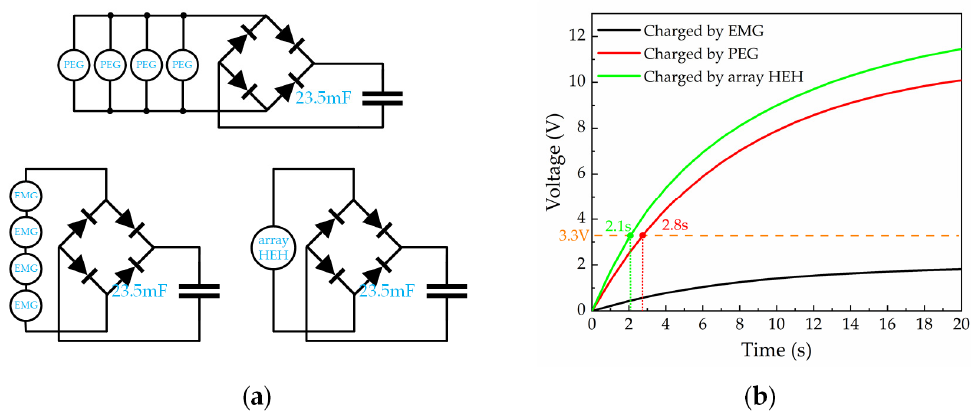
Figure 9. The experimental circuit and results of charging: ( a ) the circuit of the charging capacitors; ( b ) voltage curve showing a 23.5 mF capacitor charged by PEG, EMG, and array HEH.